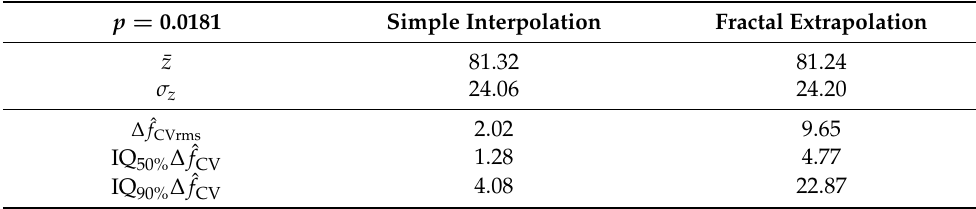
Table 3. Statistics of interpolated bathymetry with real data from the Gulf of San Jorge using the MMI interpolation without and with fractal extrapolation. Values are in